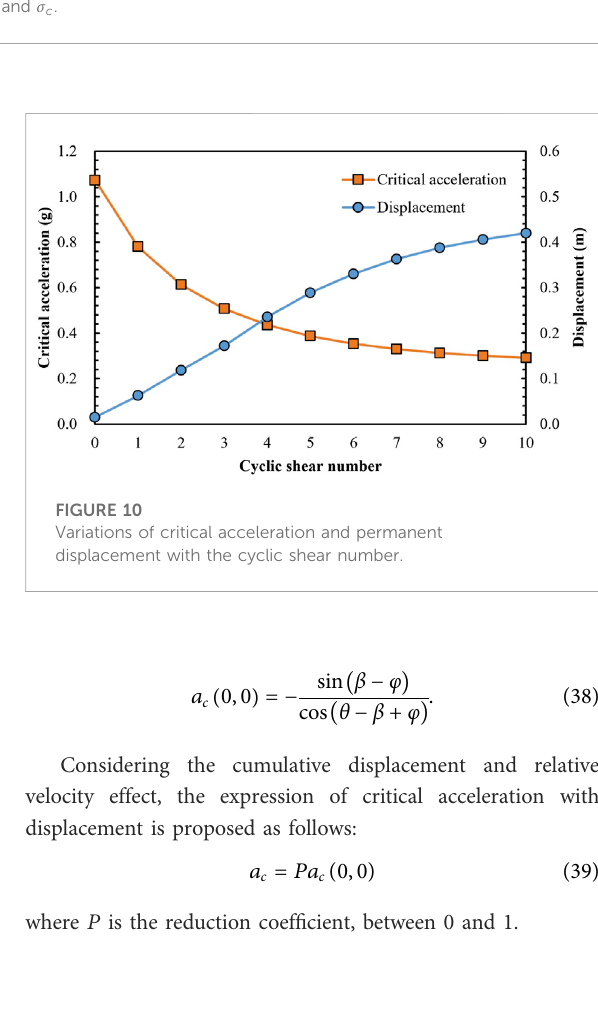
FIGURE 8 Fitting relationships of main parameters. (A) Fitting relationships between A and σ n ; (B) Fitting relationships between B and σ n ; (C) Fitting relationships between a, b and σ c ; (D) Fitting relationships between c, d and σ c .